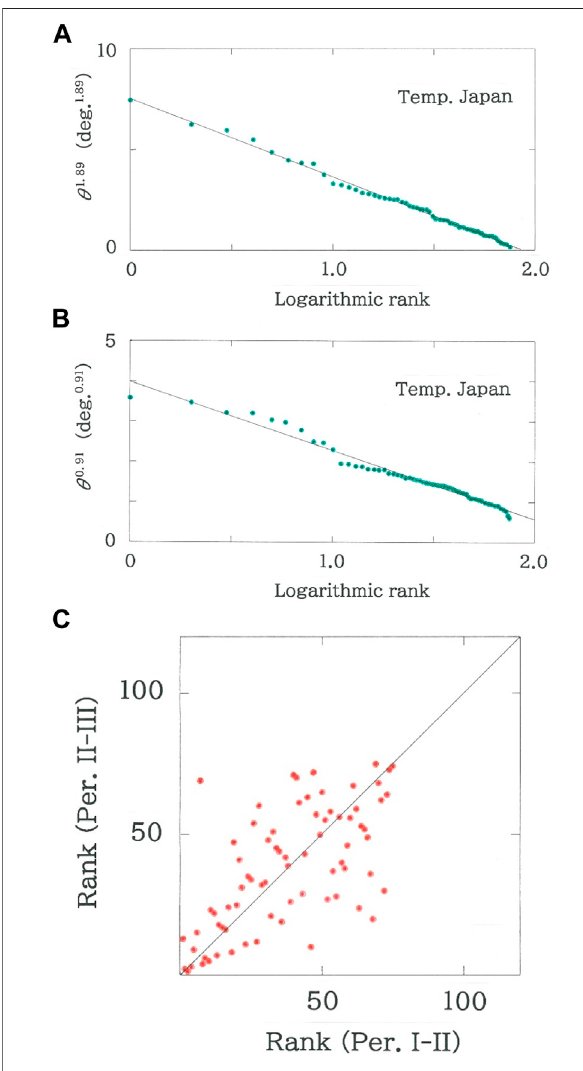
FIGURE 5 | Rank dependence of the cross angles of the monthly temperatures on the Japanese stations ( Supplementary Table S3 in Supplementary Material). (A) From Period I (from 1931 to 1960) to Period II (from 1951 to 1980). The line indicates the optimized fi t(| r | (cid:1) 0.9973 with d (cid:1) 0.662 for q (cid:1) 1.89 and n (cid:1) 75). (B) From Period II (from 1951 to 1980) to Period III (from 1981 to 2010). The line indicates the optimized fi t (| r | (cid:1) 0.9883 with d (cid:1) 0.477for q (cid:1) 0.91and n (cid:1) 75). (C) Scattergram ofrankdataofPeriod II to III versus the data of Period I to II ( r S (cid:1) 0.6381 with d (cid:1) 2.125 for n (cid:1) 75).